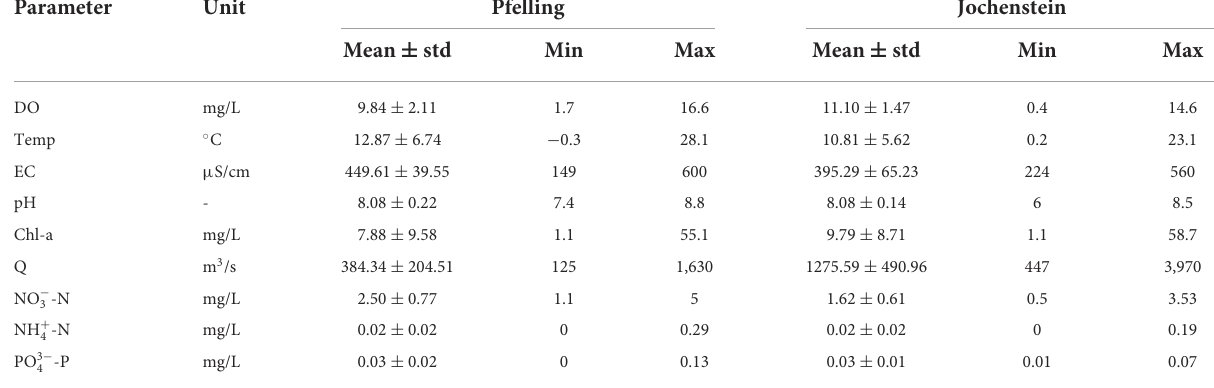
TABLE 1 Statistics of all water quality parameters in two stations.